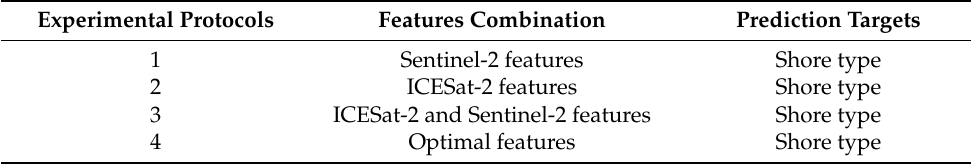
Table 3. Information of experimental